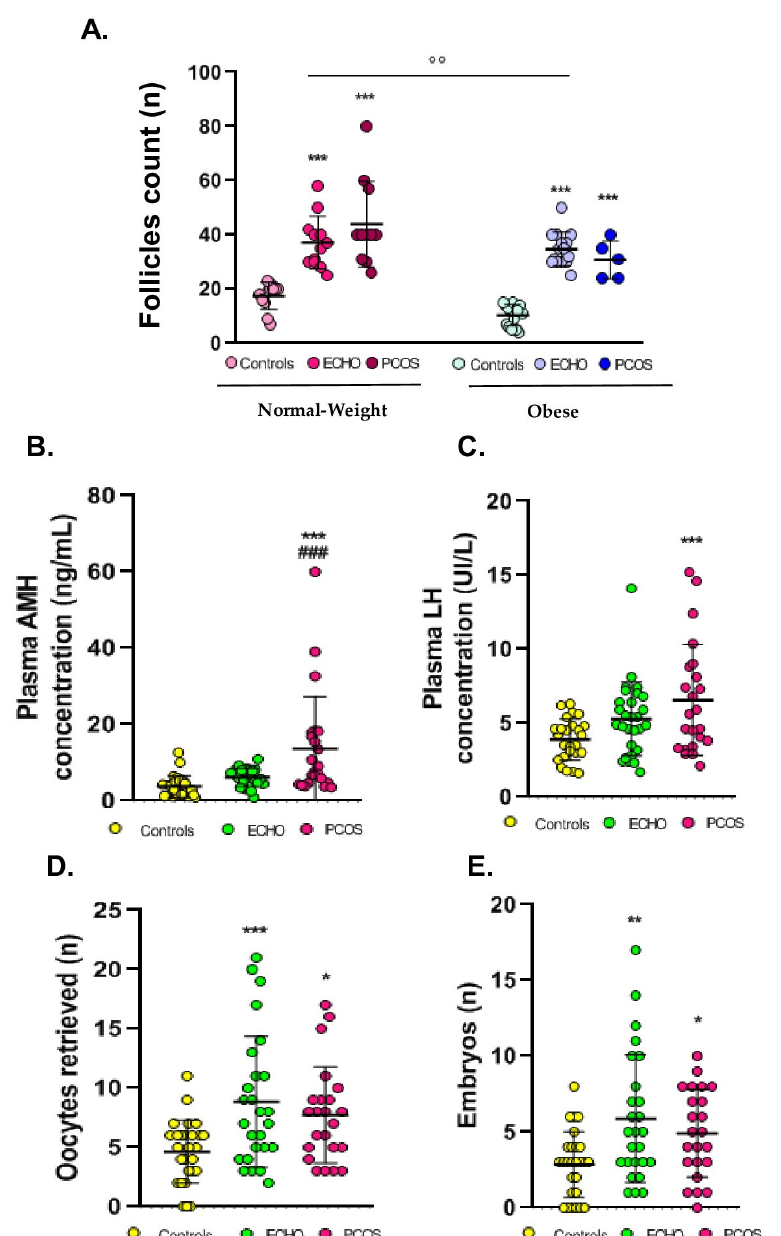
Figure 1. Clinical parameters, hormonal data, and in vitro fertilization procedure outcomes in patients of di ff erent studied groups. ( A ) Follicle counts assessed by transvaginal ultrasound, ( B ) plasma AMH concentration, ( C ) plasma LH concentration, ( D ) number of oocytes withdrawn during transvaginal retrieval, and ( E ) number of embryos obtained after in vitro fertilization. For A panel, see Table 1 for the data number per group. For the B , C , D , and E panels, the data were pooled in three groups ( n = 27, n = 28, n = 23 for controls, ECHO, and PCOS groups, respectively) according to the pathological condition, as the BMI e ff ect was not significant and no interaction between the BMI and pathological condition e ff ect was found. The values are expressed as mean ± standard errors of means. ◦◦ indicates significant di ff erence ( p < 0.01) between normal-weight and obese subjects; * indicates significant di ff erence vs. controls (* p < 0.05, ** p < 0.01, *** p < 0.001); ### indicates significant di ff erence ( p < 0.001) vs. ECHO